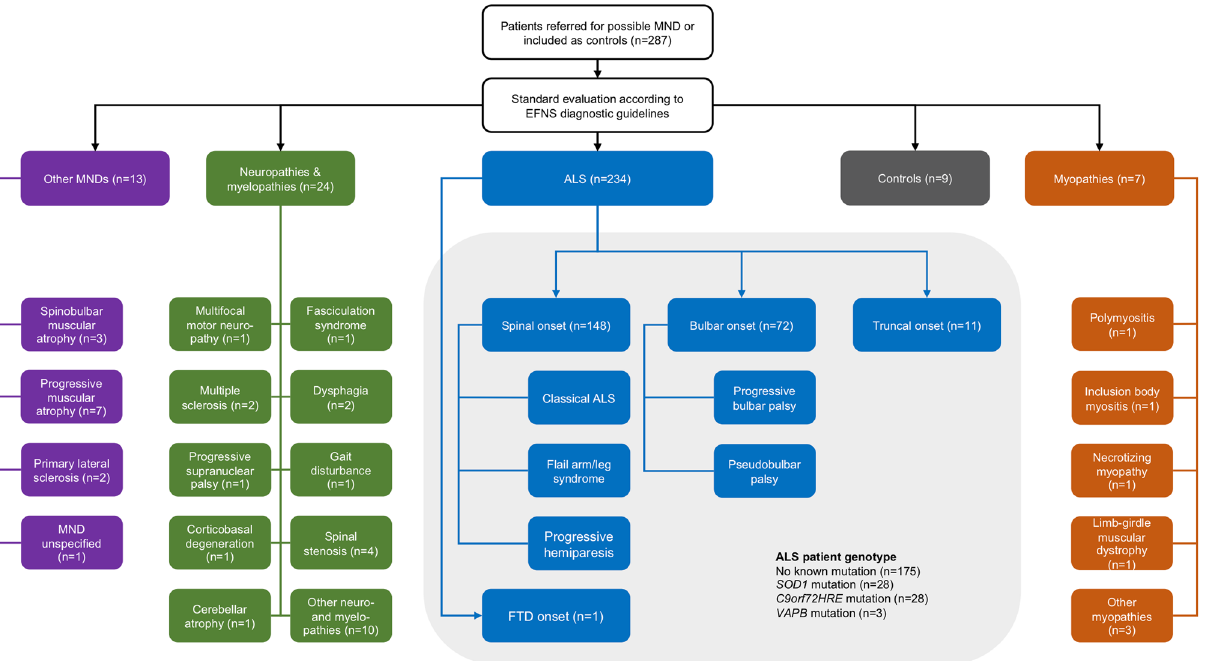
Figure 1. ALS and ALS mimics patient cohort. The study population consisted of patients who underwent investigation for possible motor neuron disease (MND) according to European Federation of Neurological Societies (EFNS) guidelines. The investigation comprised clinical evaluation, neuroimaging, neurophysiological testing (peripheral nerve conduction studies, central motor nerve conduction studies using transcranial motor evoked potentials analysis, and needle electromyography), cerebrospinal fluid and blood analysis. Patients either received an ALS diagnosis (n = 234) or an ALS mimic diagnosis (n = 44). The ALS mimic cohort consisted of patient with other MNDs (n = 13), neuropathies & myelopathies (n = 24) and myopathies (n = 7). A group of controls with no neurological symptoms was recruited for comparison (n = 9). ALS patients were grouped into spinal (n = 148), bulbar (n = 72), truncal (n = 11) or FTD (n = 1) groups according to the site of first onset. ALS patients were also stratified into carriers of mutations in SOD1 (n = 28), C9orf72HRE (n = 28), VAPB (n = 3) or patients with no mutation in these genes (n =